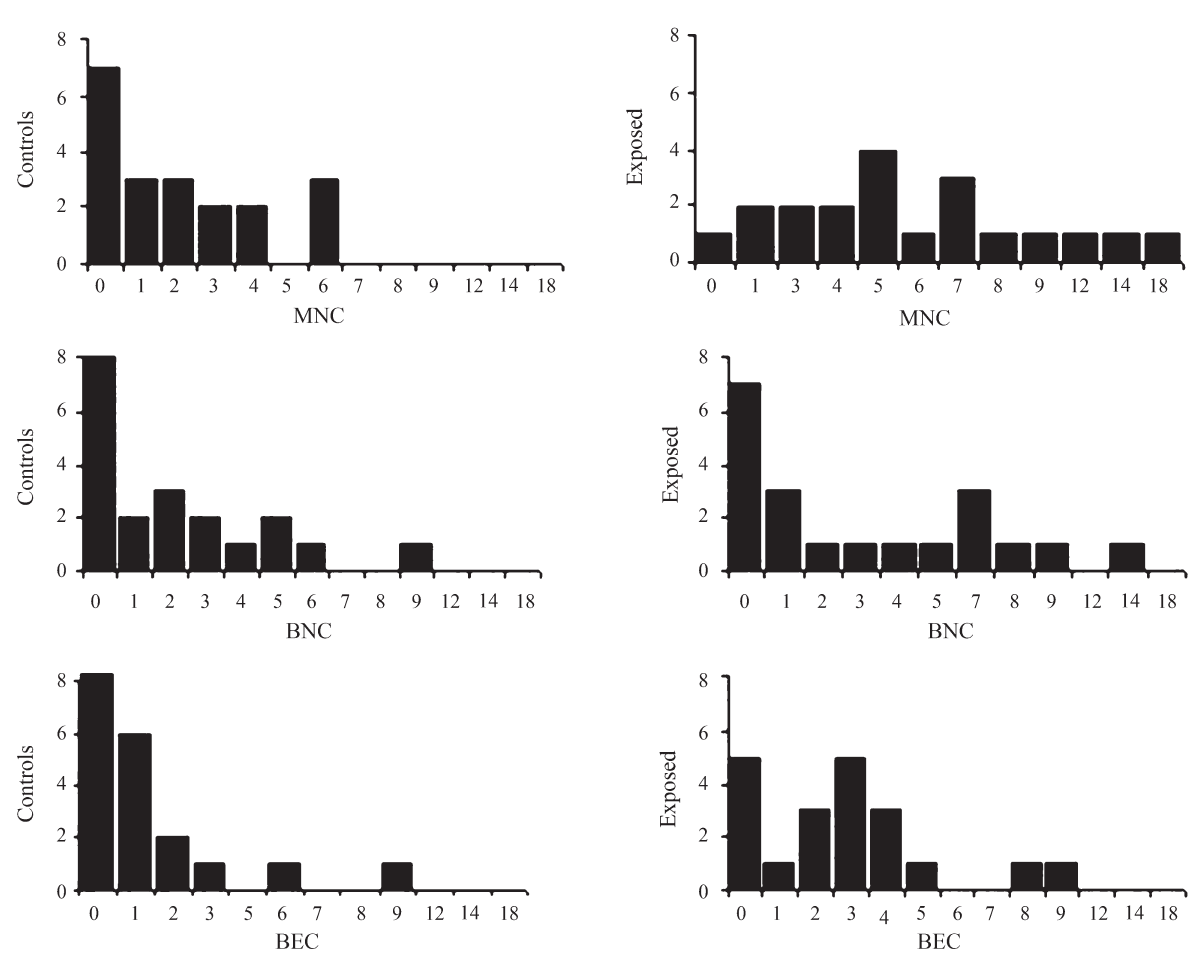
Figure 1 - Distribution of number of cells with micronuclei (MNC), binucleated (BNC) and broken egg (BEG) cells (2,000 cells per individual).